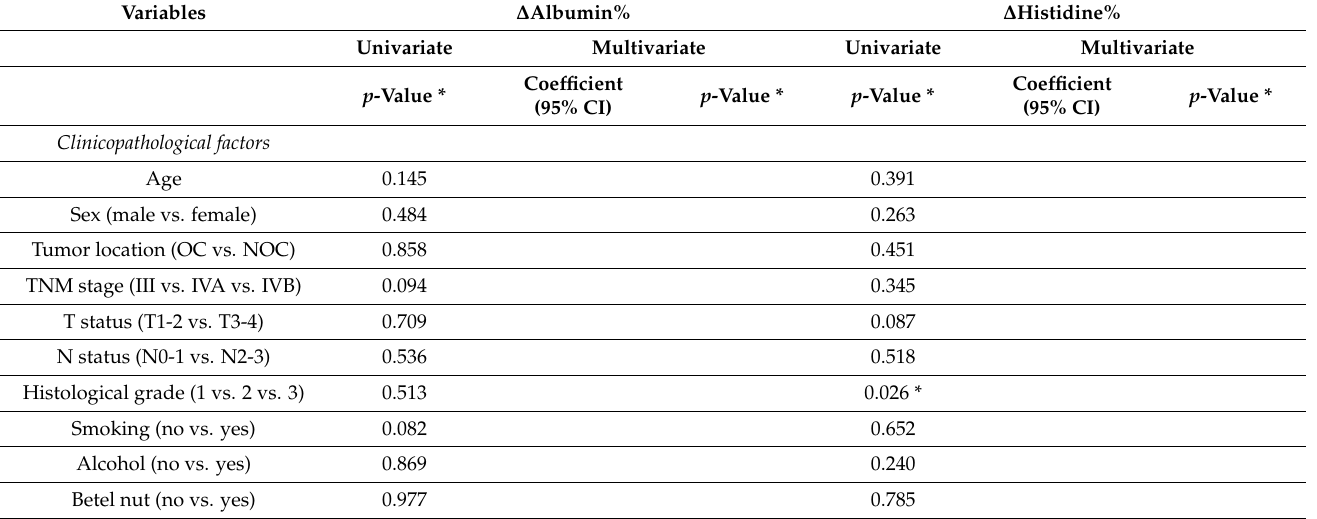
Table 5. Univariate and multivariate associations of risk factors with interval changes in albumin and histidine levels over the CCRT course in 44 patients with LAHNSCC completing